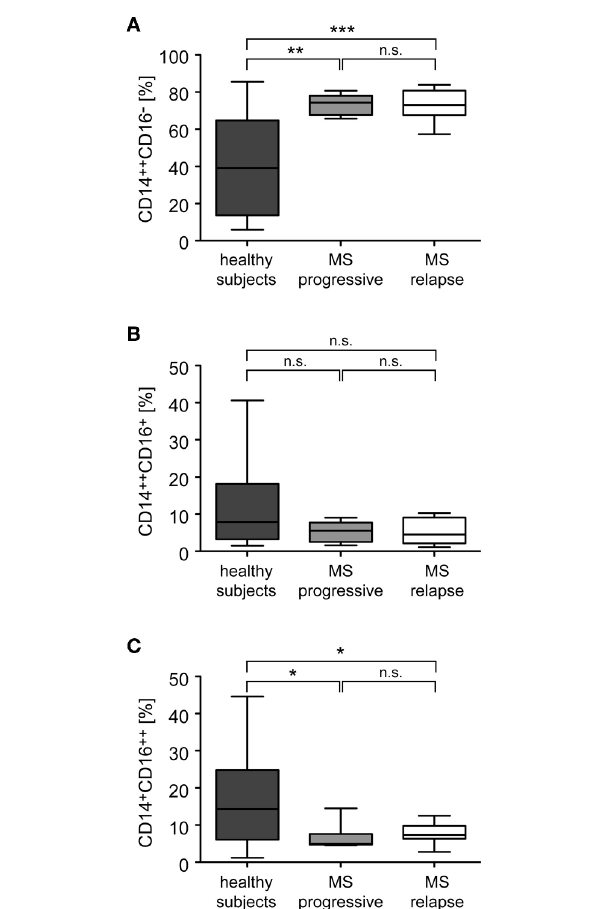
FIGURE 2 | Distribution of monocyte subsets in the peripheral blood of healthy subjects and MS patients with progressive disease or an acute relapse. Monocytes were isolated from the peripheral blood and the percentages of CD14 ++ CD16 − inflammatory monocytes (A) , CD14 ++ CD16 + intermediate state monocytes (B) , and CD14 + CD16 ++ non-classical monocytes (C) were determined by flow cytometry. MS patients were divided into two groups according to their disease activity (progressive, relapse). Data are presented as box-and-whiskers plots showing the minimum, maximum and median; n = 20 (healthy subjects), n = 8 (MS progressive), n = 12 (MS relapse). Statistical analysis was performed using a One-way ANOVA and Newman-Keuls Multiple Comparison test. Levels of significance: n.s. p ≥ 0.05; * p < 0.05; ** p < 0.01; *** p < 0.001.